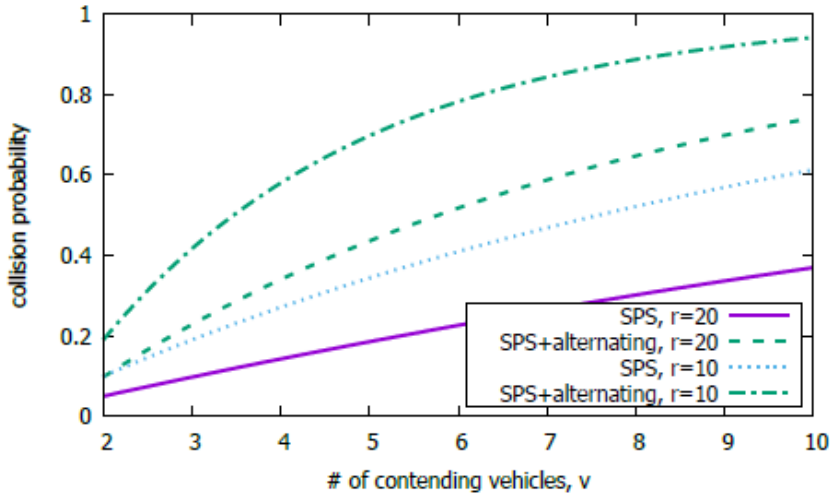
Figure 10. Increased collision probability with SPS + alternating.